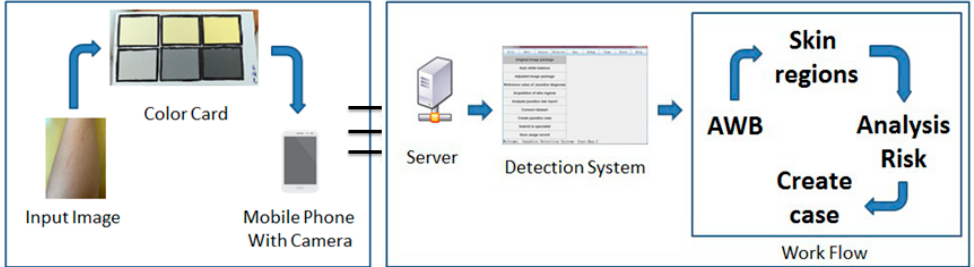
Figure 1. Detection system preprocessing flow chart.